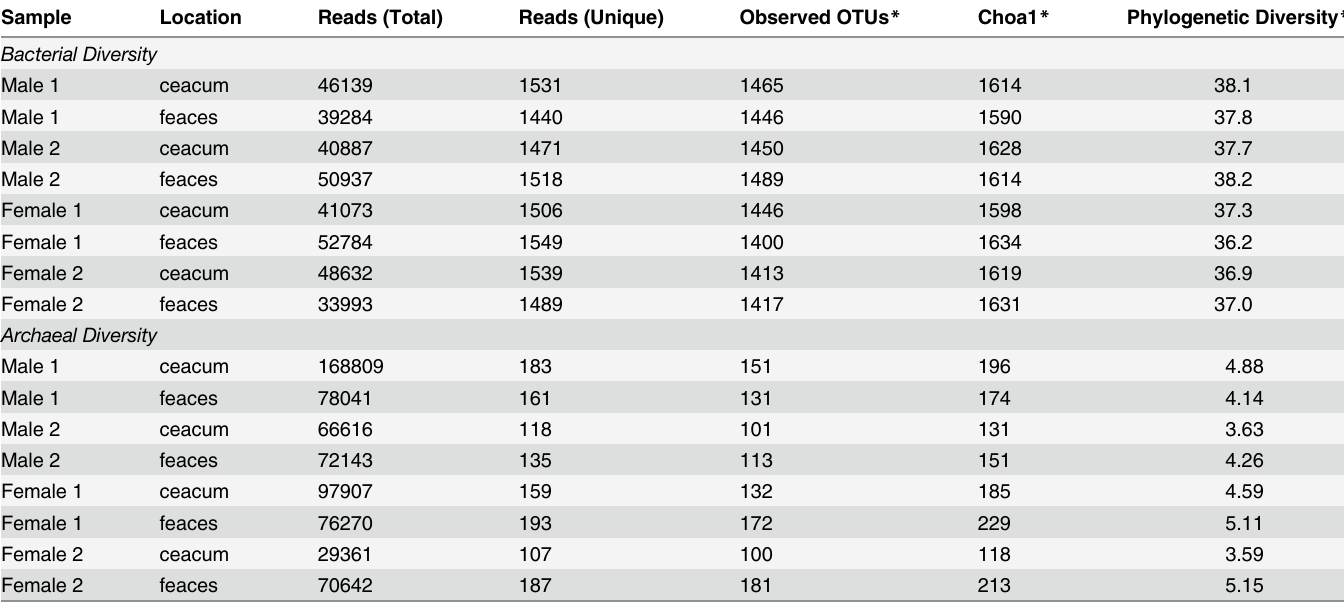
Table 1. Summary of 16S rRNA gene sequencing of beaver ceacum and feacal samples for bacterial and archaeal diversity analysis. Sample